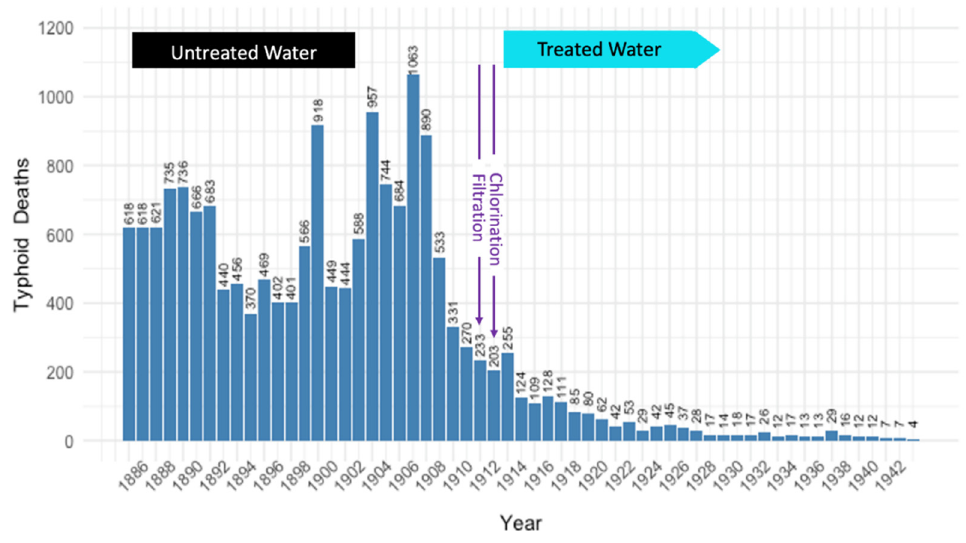
Figure 9. The number of typhoid deaths in Philadelphia was drastically reduced following the city-wide water filtration (1912) and chlorination (1913) system. Data from the Philadelphia Water Department Collection (Adapted from [33] ).